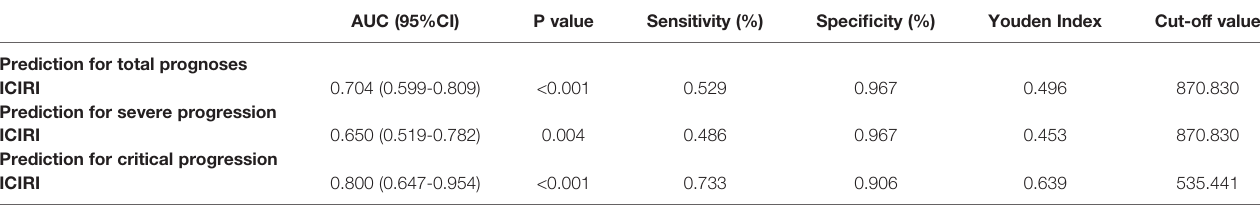
TABLE 3 | The parameters results of ROC cure analysis.